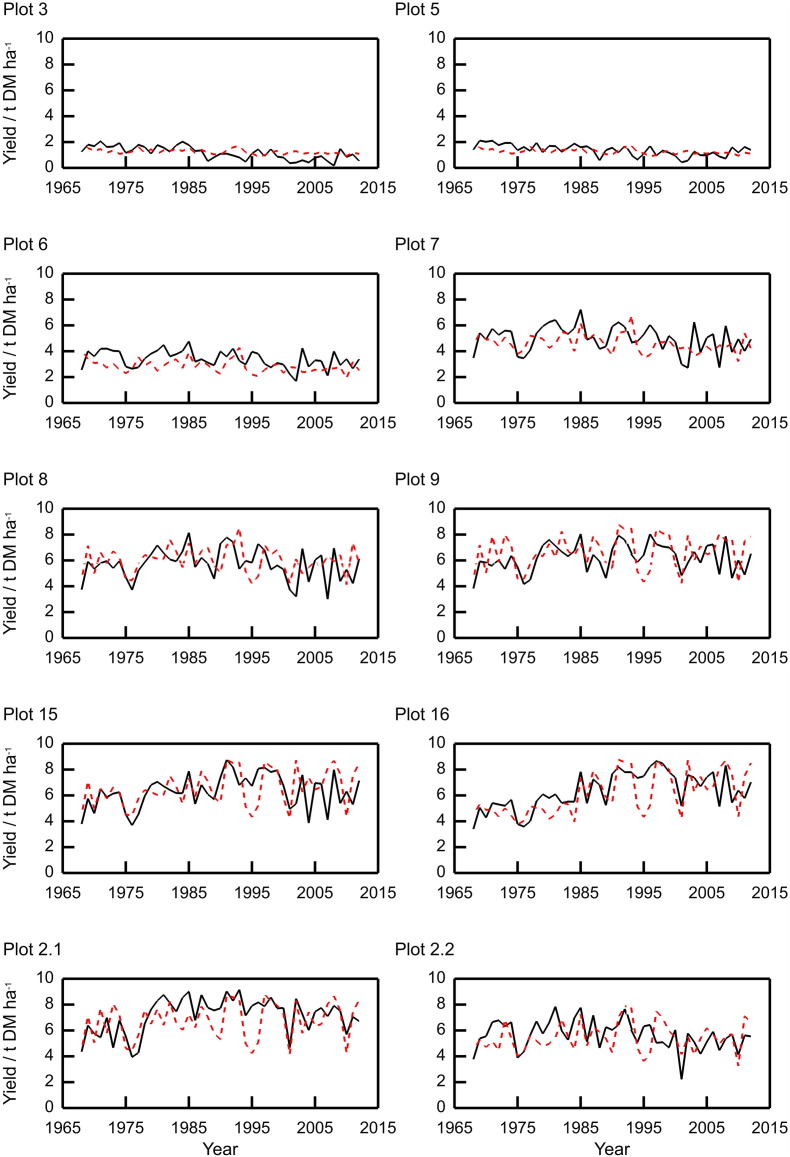
Measured (black lines) and modelled (red dashed lines) grain yields for ten plots from the Broadbalk long-term wheat experiment, 1968–2012, continuous wheat (Sections 1 and 9). The measured values were averaged over Sections 1 and 9 (see 2.9.1).